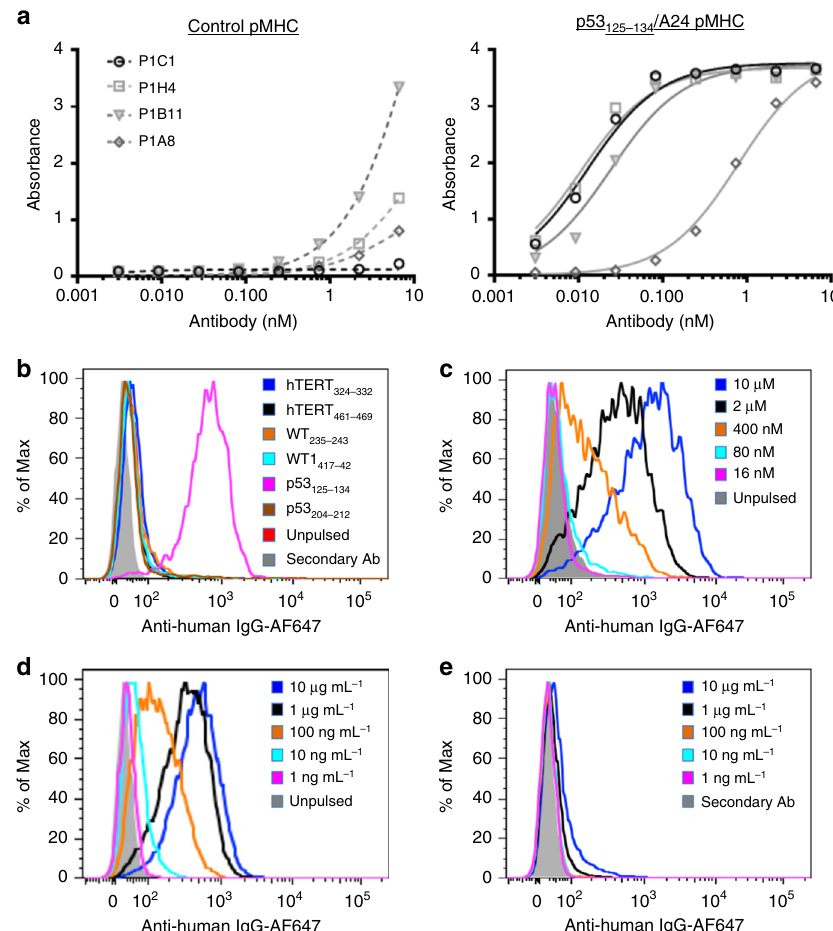
Fig. 1 Identi fi cation of TCRL antibody P1C1 speci fi c for the p53 125 – 134 /A24 pMHC. a Binding speci fi city and avidity of four leads, P1C1, P1H4, P1B11 and P1A8, to a control hTERT 461 – 469 /A24 pMHC (left) and the target p53 125 – 134 /A24 pMHC was analysed by ELISA. b A24 + , p53-null SaoS2 cells pulsed with 10 μ M six known A24-restricted peptides were stained with 10 µ g mL − 1 of P1C1 antibodies. Staining was observed only with cells pulsed with the p53 125 – 134 peptide. P1C1 binding was further analysed by c staining SaoS2 cells pulsed with a range of p53 125 – 134 peptide concentrations or d staining 10 μ M p53 125 – 134 peptide-pulsed SaoS2 cells with a range of antibody concentrations. e A24 + , mutant p53 R273H -expressing HT29 cells were stained with a range of antibody concentrations of P1C1. Data are representative of two or more independent most signi fi cant improvement in binding af fi nity as compared to 2E3 (69 nM) and 1G7 (66 nM) (Supplementary Fig. 2).